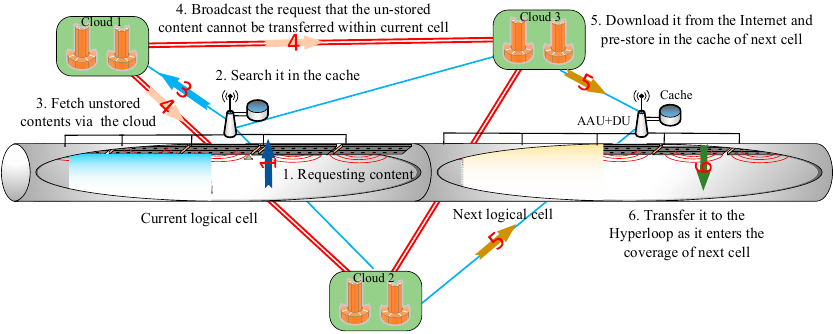
Figure 10. The diagram of the pre-fetching scheme.